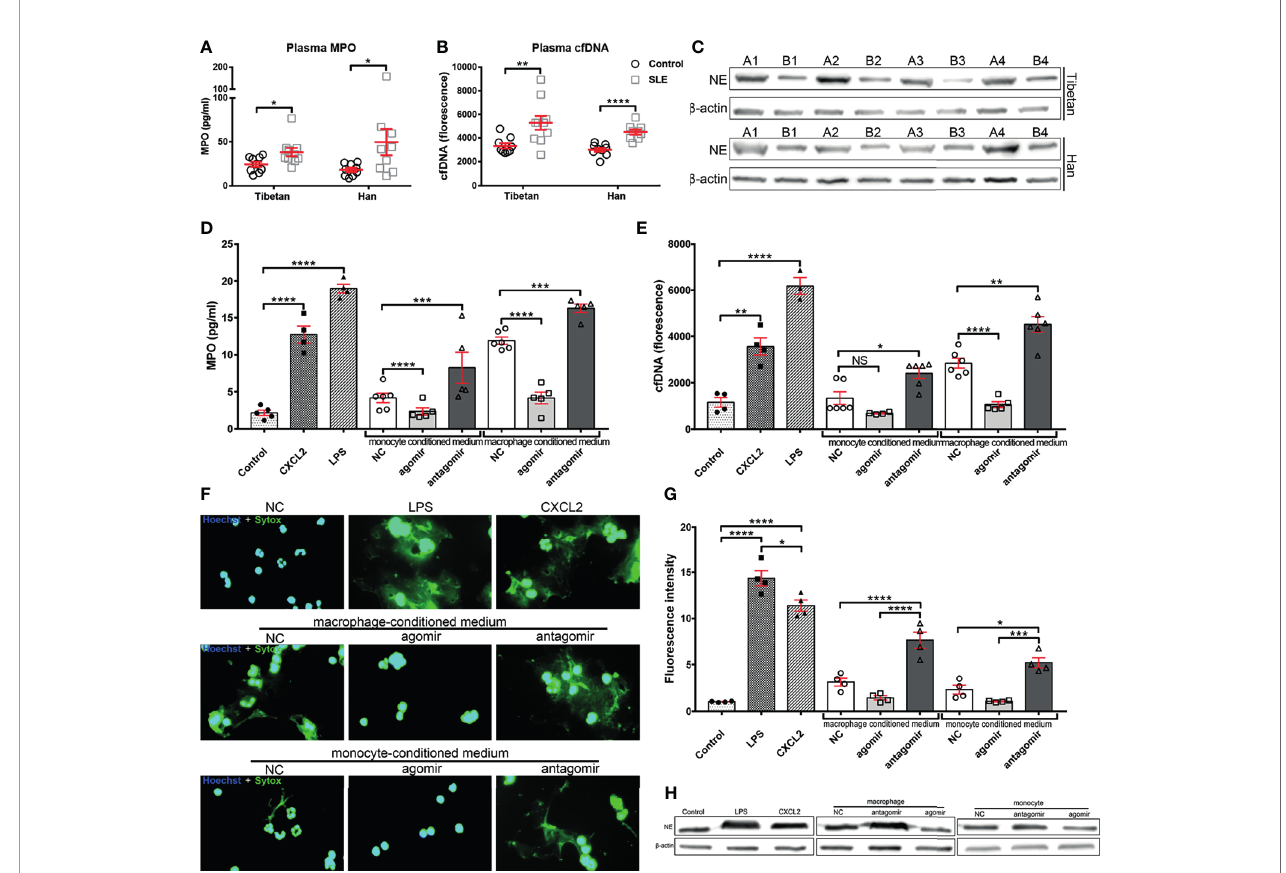
FIGURE 4 | Supernatants of monocytes and macrophages transfected with miR-4512 promote neutrophil extracellular traps formation. (A, B) Plasma levels of myeloperoxidase (MPO) (A) and cell-free DNA (cfDNA) (B) in SLE patients and control subjects from Tibetan and Han populations. Data are presented as the mean ± SEM. **** P < 0.0001, ** P < 0.01, * P < 0.05. (C) Western blot analysis of neutrophil elastase (NE) expression in neutrophils isolated from SLE patients (A1 – A4) and control subjects (B1 – B4) from Tibetan and Han populations. Results are representative of three independent experiments, with actin used as an internal control. (D, E) MPO (D) and cfDNA (E) levels in the supernatants of human primary neutrophils culture stimulated with a supernatant of monocytes and macrophages transfected with NC/miR-4512-agomir/antagomir. Neutrophils directly stimulated with LPS or CXCL2 were used as positive controls. Data are presented as the mean ± SEM. **** P < 0.0001; *** P < 0.001; ** P < 0.01; * P < 0.05; NS, not signi fi cant. (F) Images of neutrophils stimulated with macrophage and monocyte conditioned medium or with CXCL2 and LPS. Nuclei were stained with Hoechst (blue) and the presence of extracellular DNA were stained with Sytox Green. Images are representatives of three independent experiments. (G) Quanti fi cation of neutrophils extracellular DNA during NETosis by Sytox Green assays. Data are presented as the mean ± SEM. **** P < 0.0001; *** P < 0.001; * P < 0.05. (H) Western blot analysis of elastase expression in neutrophils after stimulation. Images are representatives of three independent